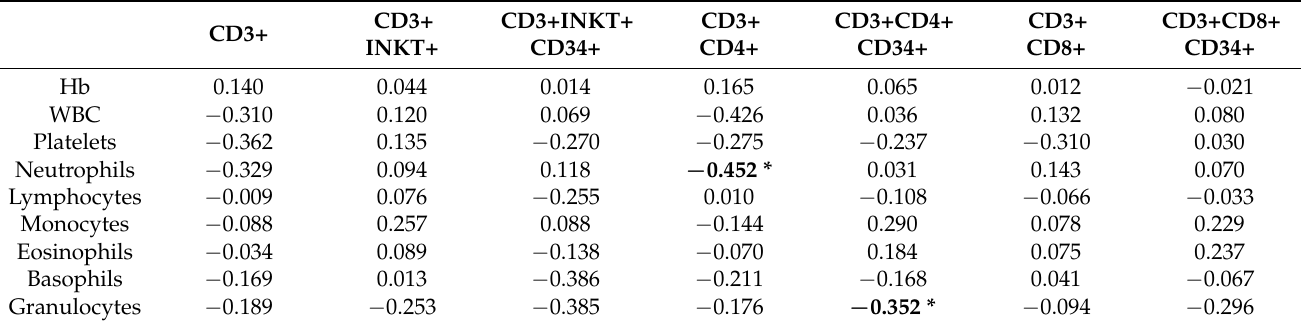
Table 10. Correlations between umbilical cord blood lymphocyte subsets and maternal blood cells count. Pearson’s significant correlation coefficients have been highlighted.